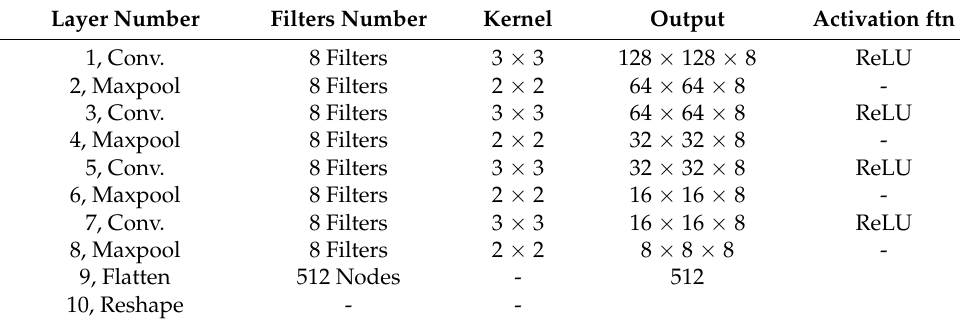
Table 2. Architecture of the convolutional